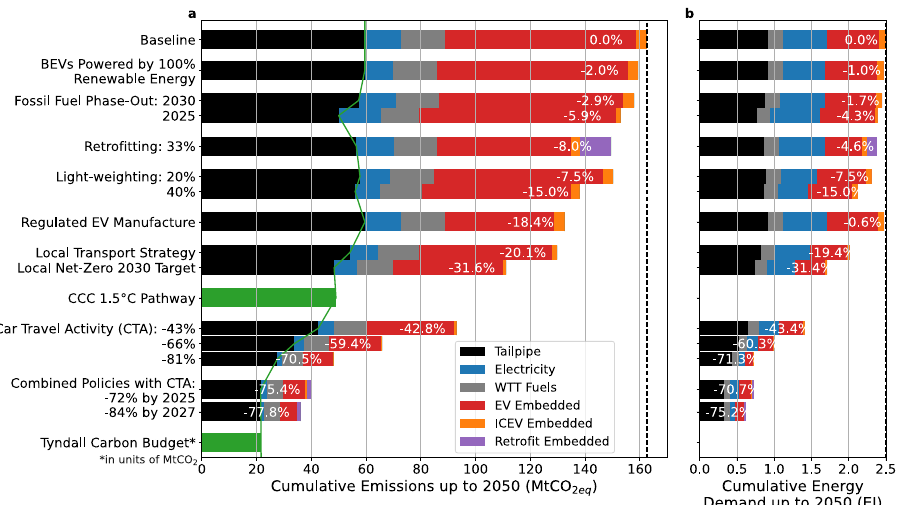
Fig. 1 | London car cumulative CO 2eq emissions and energy demand under differentpolicies. Cumulativeemissions( a )andenergydemand( b )between2020 and 2050 is shown for the baseline case and each policy applied onto the baseline case, as well as the local transport policy for London and a combined case con- sisting of all policies acting together. Emission projections are compared with the Tyndall Centre ’ s estimate of the carbon budget (for well below 2°C and pursuing 1.5°C) 46 multiplied by the historical percentage of London ’ s emissions from cars 47 and the CCC ’ s cumulative emissions pathway for 1.5°C for surface transport 10 multiplied by the historic percentage of UK surface transport emissions arising